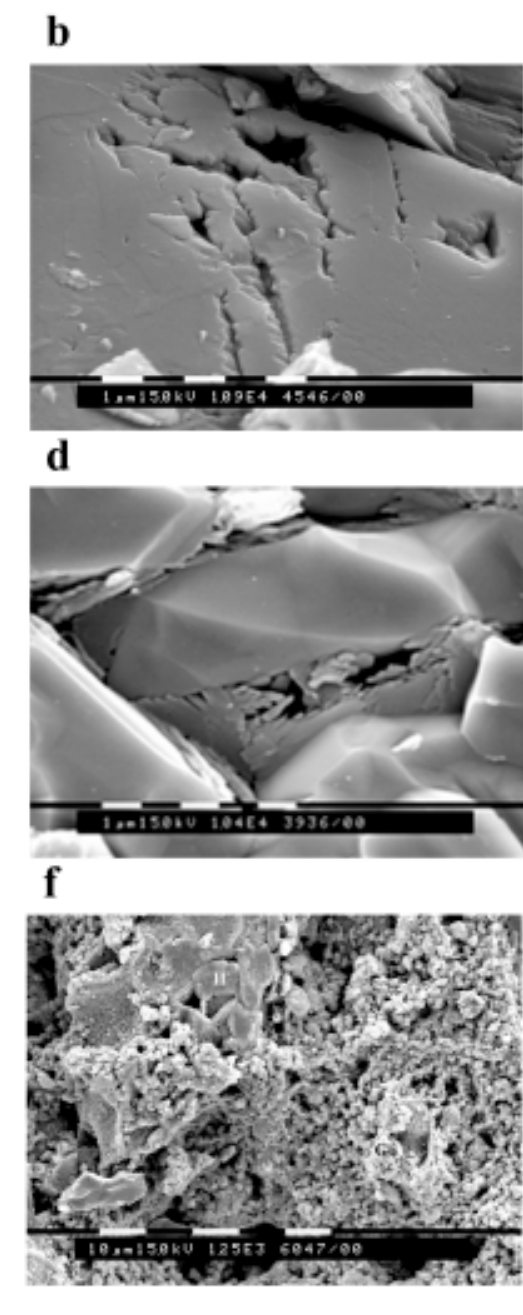
Fig. 4–(aandb)SEMmicrographsshowingroundedmicroporesassociatedwithaneuhedralmartitecrystal,(dande)SEMmicrographs showing micropores in non-orientated microplaty hematite; (f) SEM micrograph showing micropores in dissolution cavity, partially filled by secondary goethite; (g) SEM micrograph showing micropores associated with goethite.